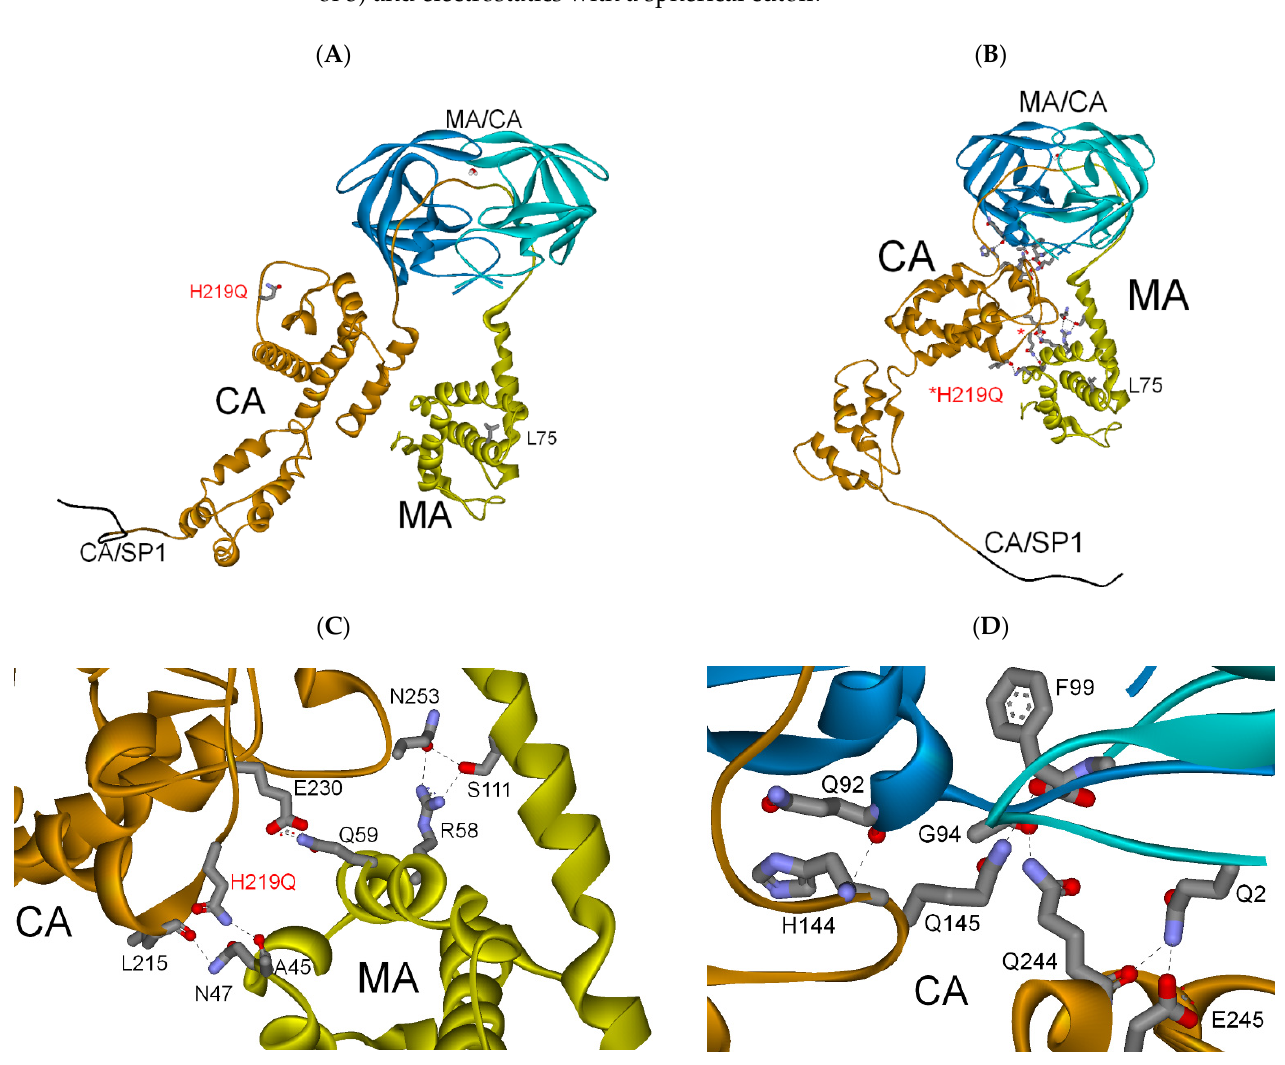
Figure 5. ( A ) HIV-1 PR (front view) bound to MA/CA cleavage site in MA-CA-SP1 polyprotein, PR backbone as ribbon (A-subunit teal, B-subunit blue), MA-CA-SP1 polyprotein backbone as ribbon, MA yellow, CA bronze, MA/CA and CA/SP1 cleavage sites indicated, SP1 backbone black, Gag non-cleavage site PI resistance residue CA H219Q (red label) and MA L75 (black label) shown (carbon grey, oxygen red, nitrogen blue), tetrahedrally coordinated active site water shown; ( B ) PR (front view) bound to MA-CA-SP1 with a substrate-clamp between MA and CA subdomains coordinated by the H219Q Gag non-cleavage site PI resistant mutation (red label, center), MA L75 shown (black label), MA and CA subdomain residues involved in substrate-clamp shown (carbon grey, oxygen red, nitrogen blue), H-bonds as black dashed lines; ( C ) close-up of substrate-clamp H-bond network between MA and CA subdomains, native MA residues (right side) N47, A45, Q59, R58, S111, and native CA residues (left side) L215, E320, N253, as well as the Gag non-cleavage site PI resistance mutation H219Q (red label, center); ( D ) close-up of substrate-clamp mediated H-bond interactions between CA subdomain and PR, CA residues left to right, H144, Q145, Q244, and E245 and PR A-subunit Q2 and C-terminal F99 (right) and PR B-subunit Q92 and G94 (left), see Results and Discussion Section 3.2.3. for detailed description of the substrate-clamp H-bond network.